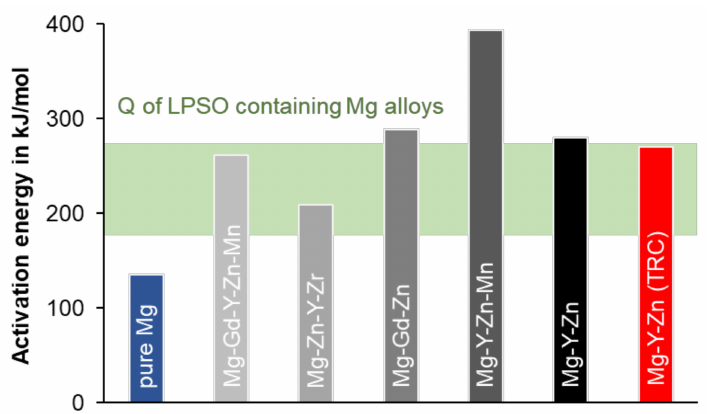
Figure 7. Activation energy Q of LPSO containing magnesium alloys compared to pure Mg